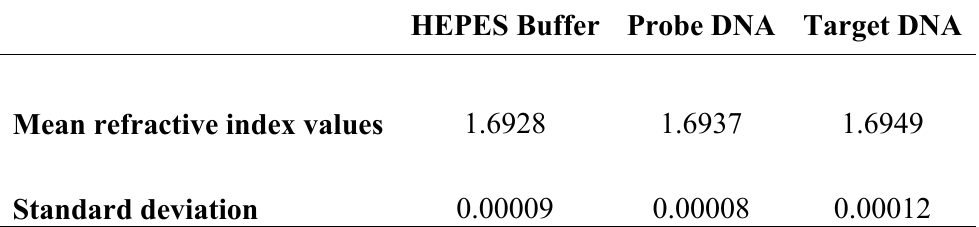
Table 1. Mean refractive index values and their standard